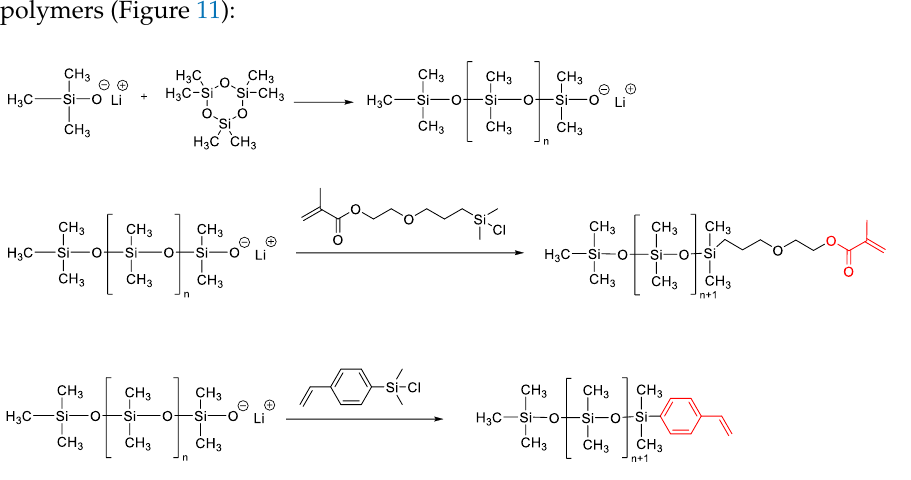
Figure 11. Obtaining monofunctional macromonomers of the styrene and methacrylate type by the AROP mechanism.